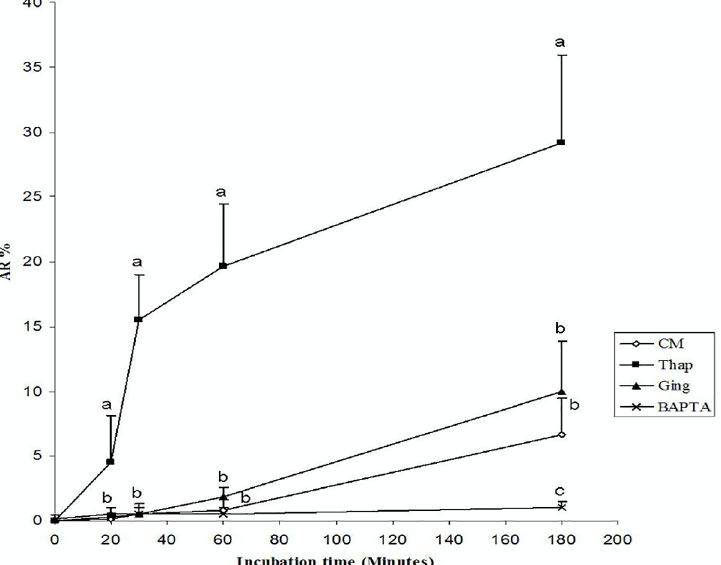
Fig 4. Effect of sperm incubation in capacitation medium with thapsigargin, gingerol or BAPTA-K+ on the AR. Washed porcine sperm were cultured in capacitation medium without any chemical modulators (control), or with thapsigargin, gingerol (Ging) or BAPTA-K+ (BAPTA) and stained with PSA-FITC to assess the AR (%). Different letters at 0, 20, 40, 60 and 180 minutes indicate significant differences as determined by one-way factorial analysis of variance with Fisher’s protected least significant difference (a-d: P < 0.05). The experiments were replicated three times. Data represent the mean percentages ± SD.